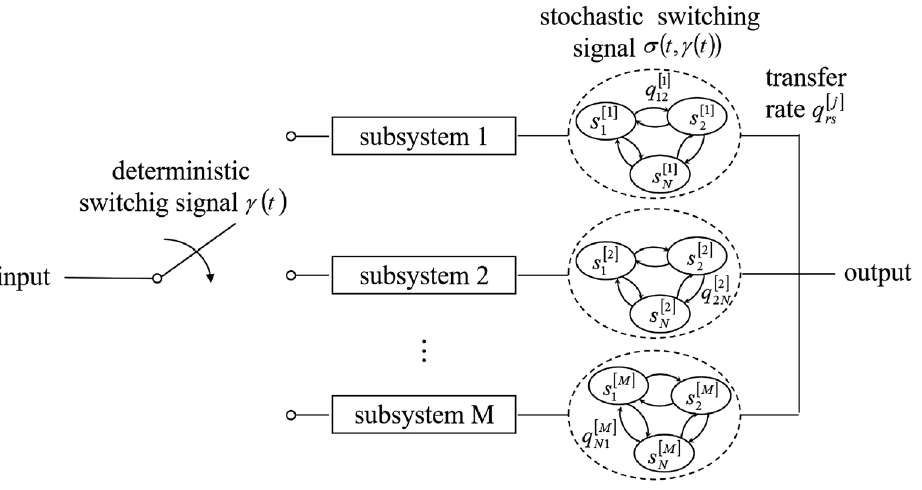
Figure 1. Structure of a